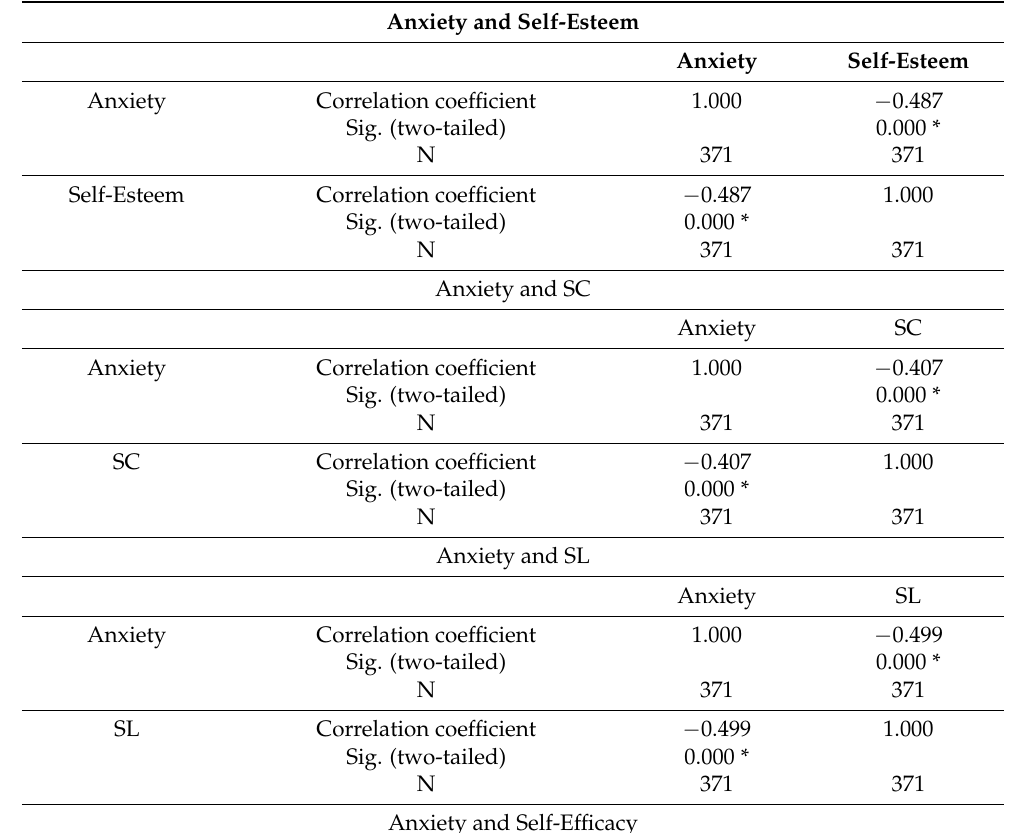
Table 4. Correlation between Psychological Factors and Anxiety among Medical